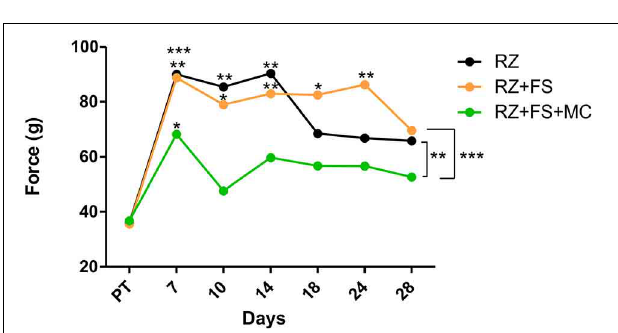
FIGURE 3 | Electronic von-Frey measurements (average values) obtained from the right hind paw (lesioned). The values are shown in grams (g) applied to trigger the “flinch” response. Statistical differences among groups are indicated with brackets. Asterisks above each dot represent the comparison between the time point and the respective pre-test. FS, fibrin sealant; PT, pretest; MC, mononuclear cells; RZ, rhizotomy.